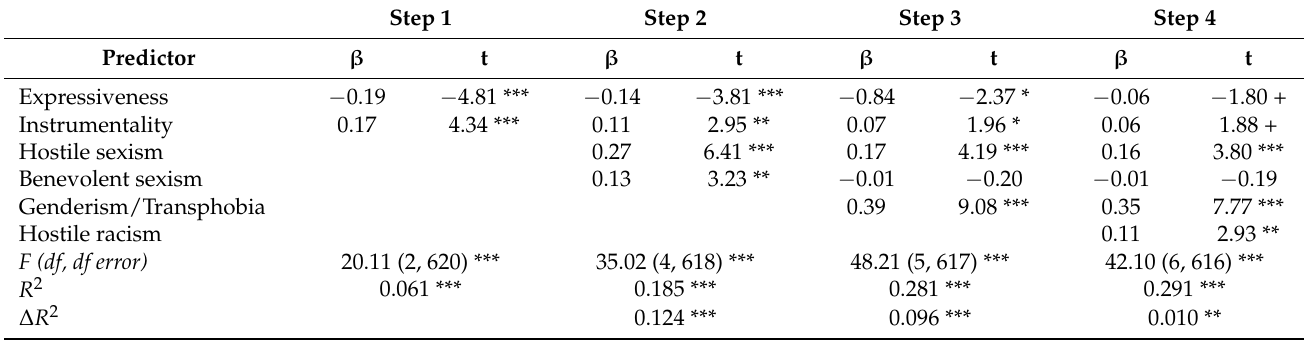
Table 3. Hierarchical linear regression analysis predicting gender-bashing.